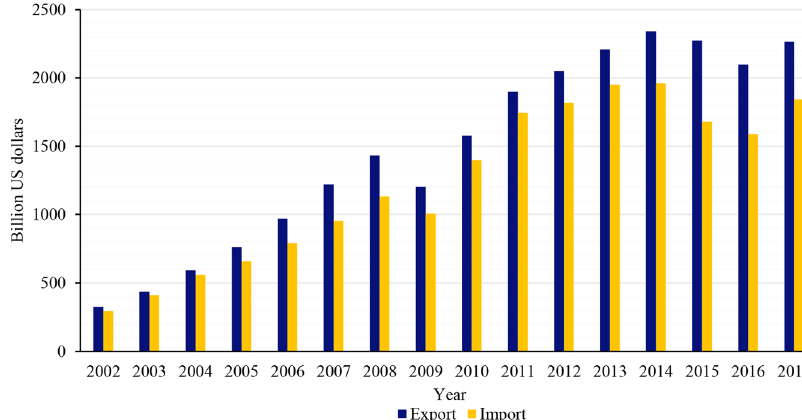
Fig. 4 China ’ s export and import from 2002 to 2017.